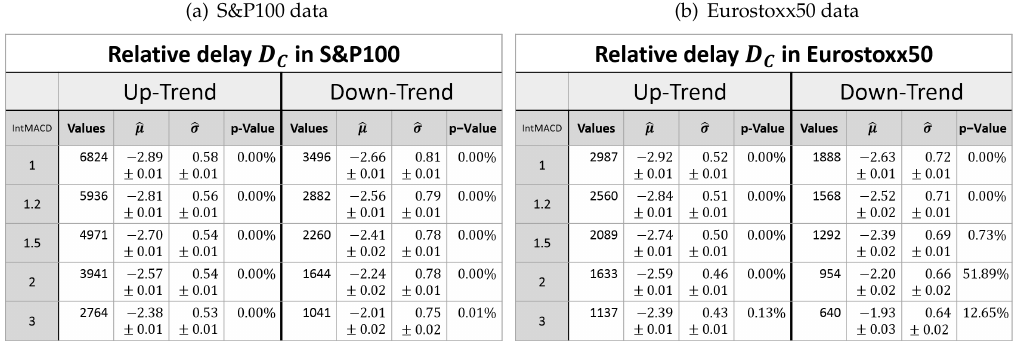
Table 9. Parameters of the log-normal fit for the relative delay D C after a correction in up- and